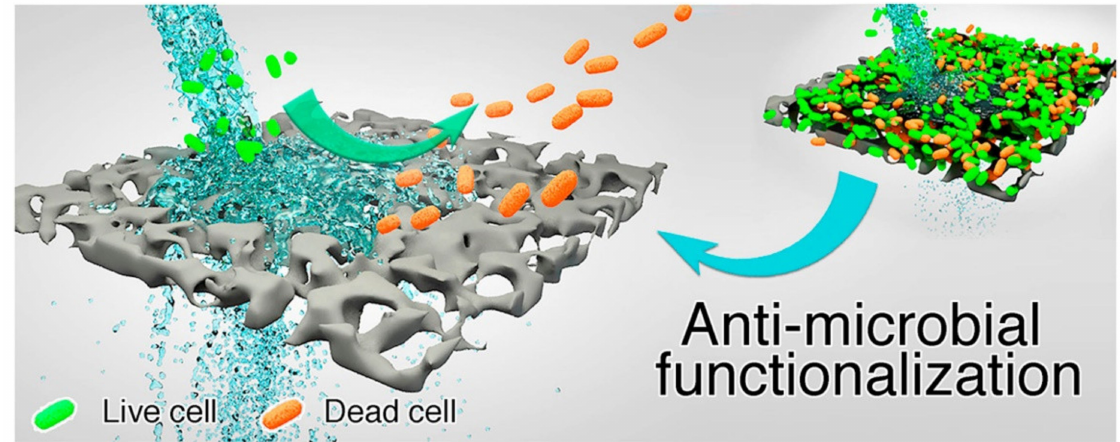
Figure 10. Illustration of antimicrobial activity on a surface of an antimicrobial membrane during water filtration. Reprinted from [124] with permission from Elsevier.